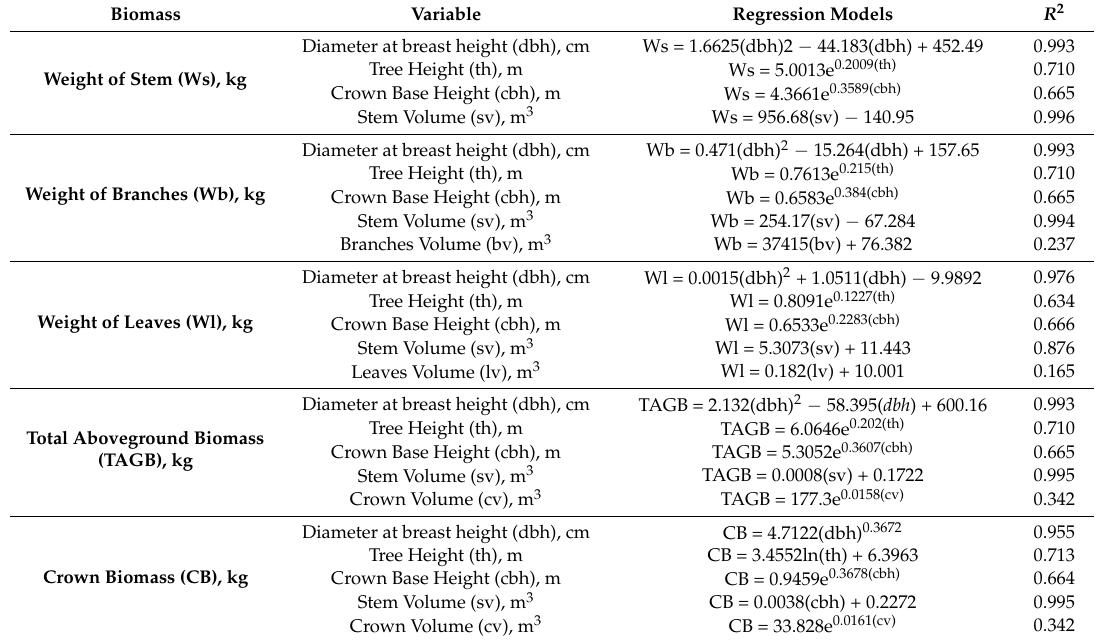
Table A6. Allometric equation generated for Kempas with tree variables obtained from TLS.